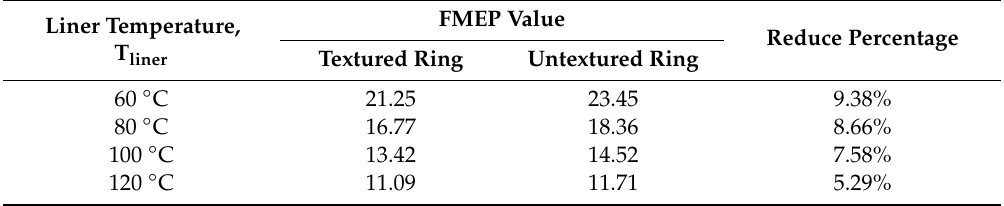
Table 4. FMEP values in the textured RLC and untextured RLC for different liner temperatures.